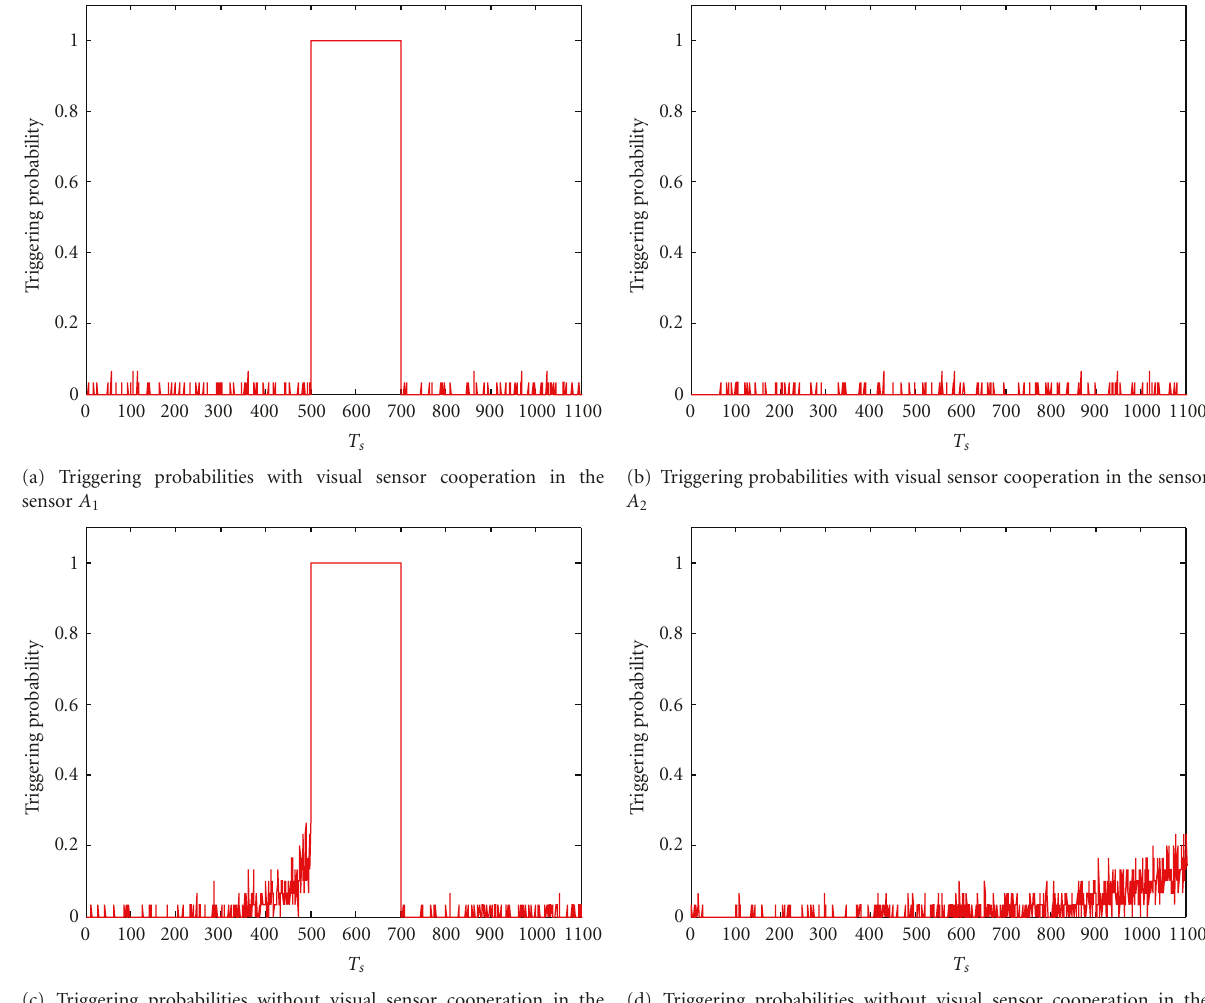
(d) Triggering probabilities without visual sensor cooperation in the sensor A 2 Figure 20: Triggering probabilities of two sensors between 501 T s and 1100 T s